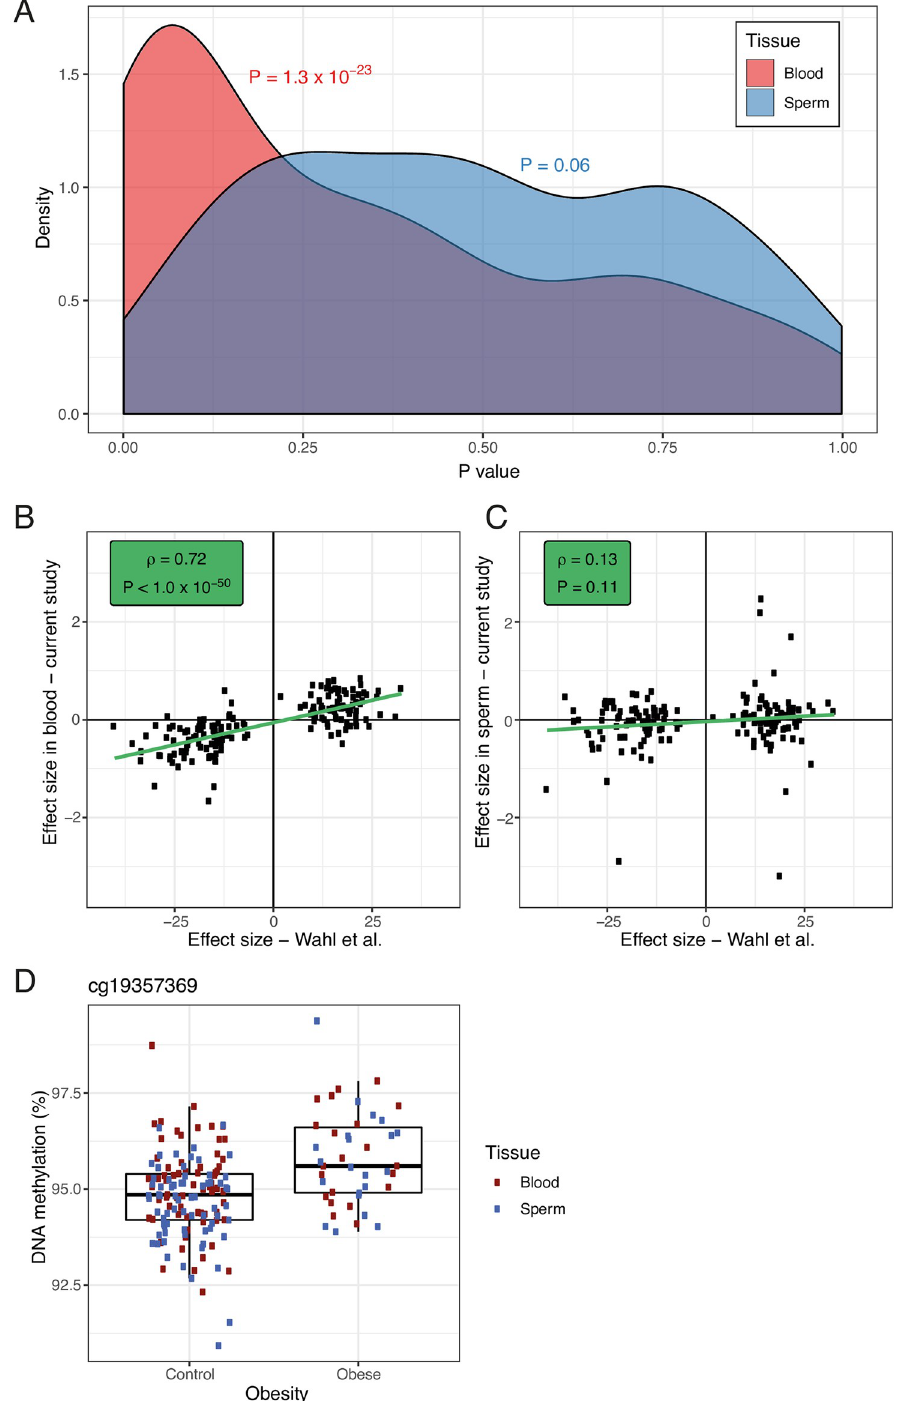
Fig 6. Obesity associated DNA methylation patterns in whole blood and sperm. Out of all replicated CpG sites reported to be associated with BMI by Wahl et al. ( P < 1.0 × 10 − 7 ), 187 were also present in our replication group of lean and obese men. We regressed BMI onto DNA methylation in each tissue, controlling for estimated blood cell types in the blood analysis to match the analysis used by Wahl and colleagues. ( A ) Lower-ranked P values were found to be enriched amongst these 187 sites in blood ( P < 1.3 × 10 − 23 , Fisher’s exact test) but not sperm ( P = 0.06). ( B )